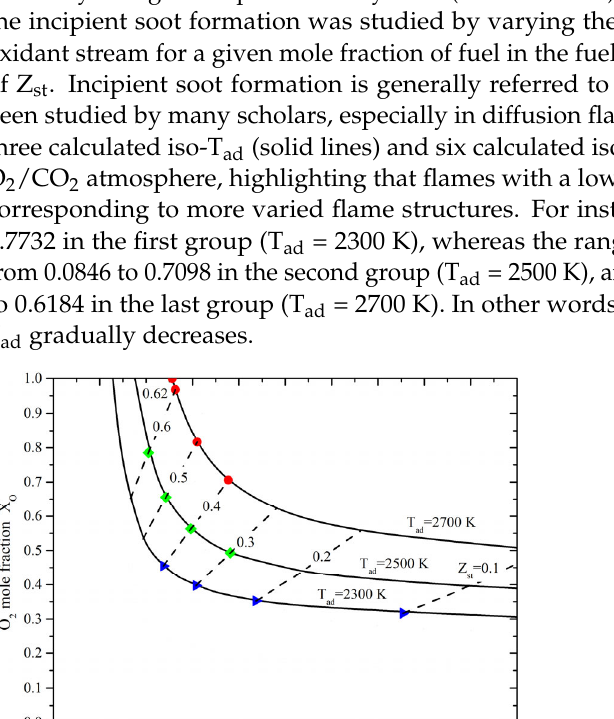
stagnation plane location in the conditions from Table 1. The abscissa is the difference between the flame sheet position and the stagnation plane location (from the fuel side), the ordinate is the stoichiometric mixed fraction Z st .